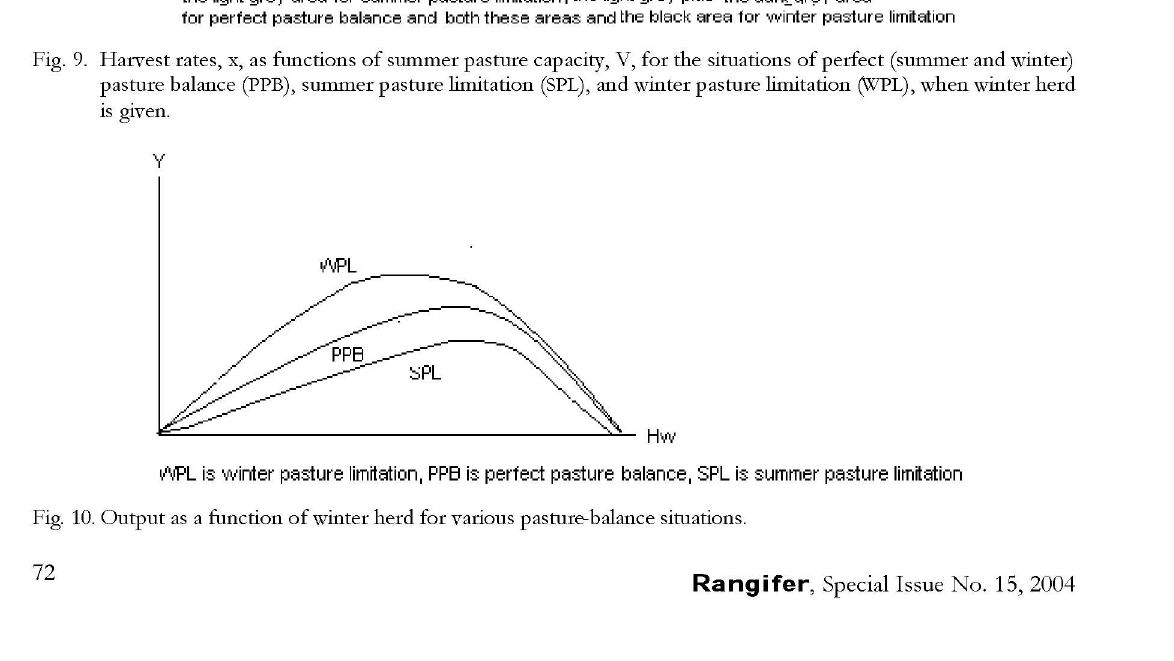
Fig. 10. Output as a function of winter herd for various pasture-balance